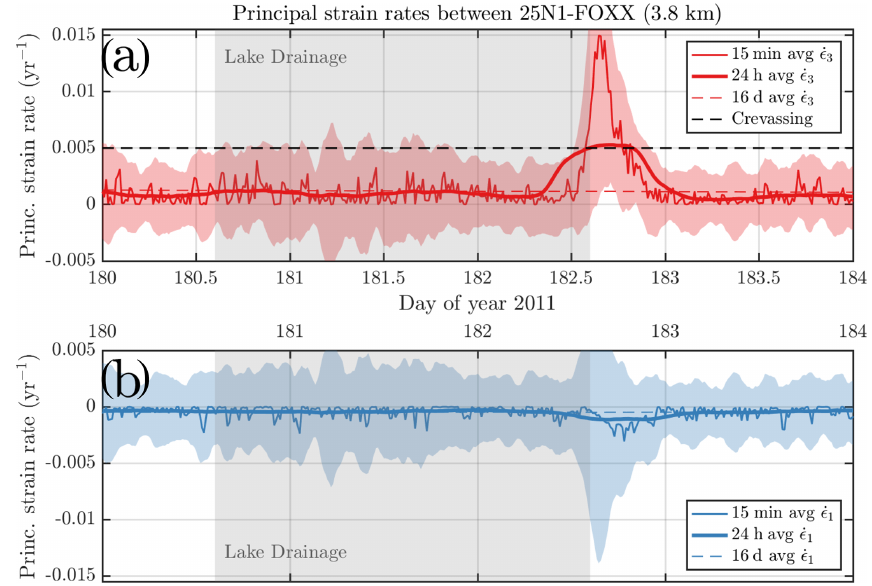
Figure 10. GPS-derived principal strain rates, ˙ (cid:15) 1 (b) and ˙ (cid:15) 2 (a) , averaged across a 3.8km distance along an approximate basal hydropotential flow path over 4d of summer 2011. Three nearby fast lake drainages (Lakes 52, 55, 64) occurred on day 181.6 ± 1d, according to Morriss et al. (2013) and this work. These lakes are respectively 12, 10, and 8km upstream from the observation midpoint between GPS stations shown here. The shaded region shows the estimated error in strain rates (Eq. 3), based on GPS location errors of approximately 0.5cm for each observation recorded at 15min intervals. The dashed black line shows the approximate strain-rate threshold for crevassing, + 0.005yr − 1 (Poinar et al., 2015; Joughin et al., 2013). GPS data are shown at 15min, 24h, and 16d averaging intervals. GPS data are from Andrews et al. (2018) and Hoffman et al.